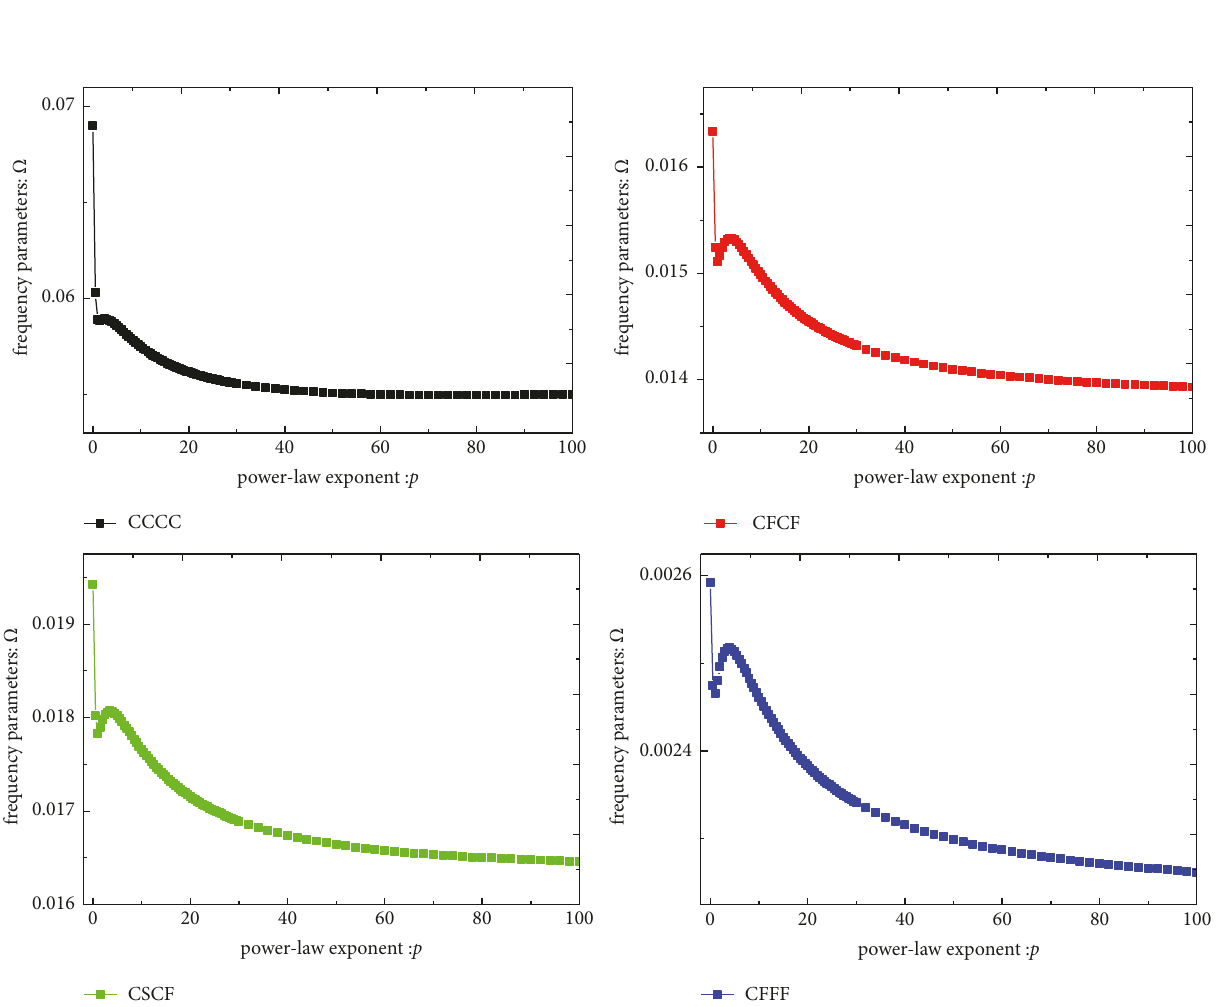
Figure 8: Variations of fundamental frequency parameter Ω versus the power-law exponent 𝑝 for Al/ZrO 2 rectangular plate with different boundary